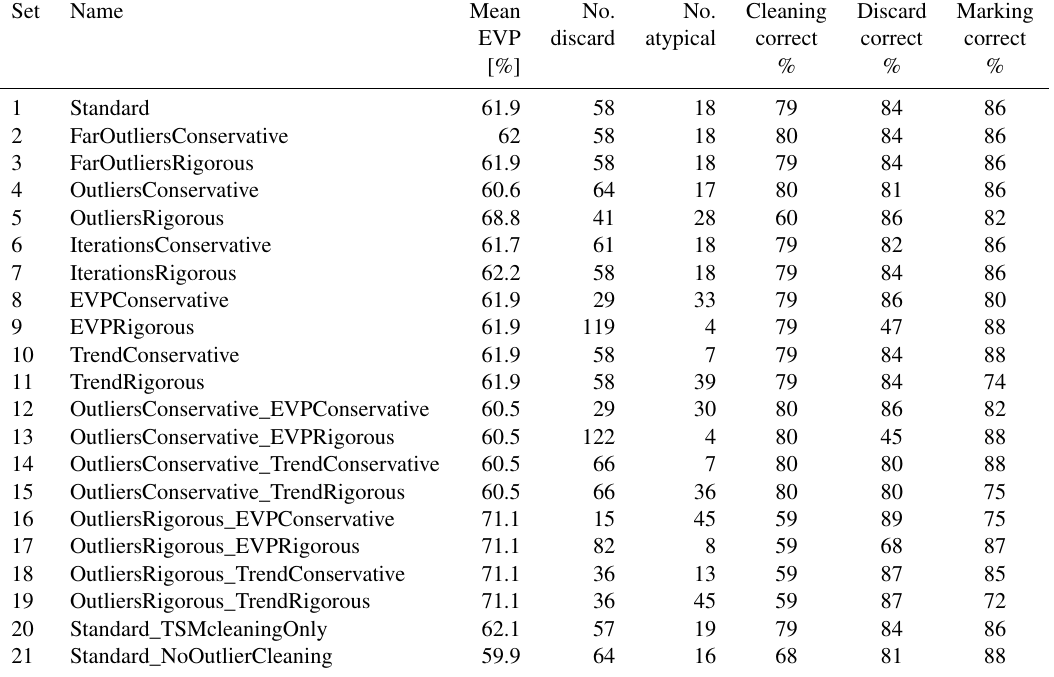
Table 4. Summary results of validation parameter sensitivity test. No. discard and No. atypical refer to the number of series discarded or marked as atypical respectively. Cleaning correct %, discard correct %, and marking correct % refer to the percentage of series with correct action identified for cleaning, discarding, and marking respectively. See Table S1 for an explanation of the parameter sets.